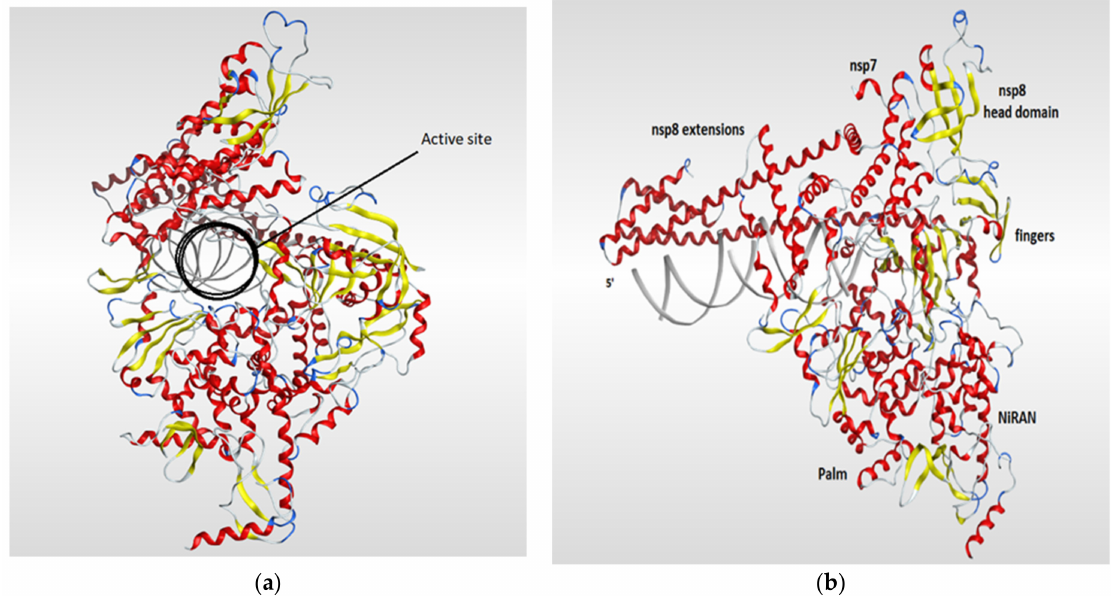
Figure 7. Ribbon representation of RdRp of SARS-CoV-2 (PDB code: 6yyt) which shows the active site of the enzyme ( a ) and illustrates the various domains of the enzyme ( b ). The RdRp structure consists of three subunits (nsp12, nsp8, and nsp7). The RdRp domain is fashioned into three subdomains (palm, fingers, and thumb subdomains). The nsp12 is mainly forms the active site of RdRb and comprised three domains (INRAN domain, C-terminal domain, and interface domain). The nsp8 and nsp7 subunits are binding to the fingers and thumb